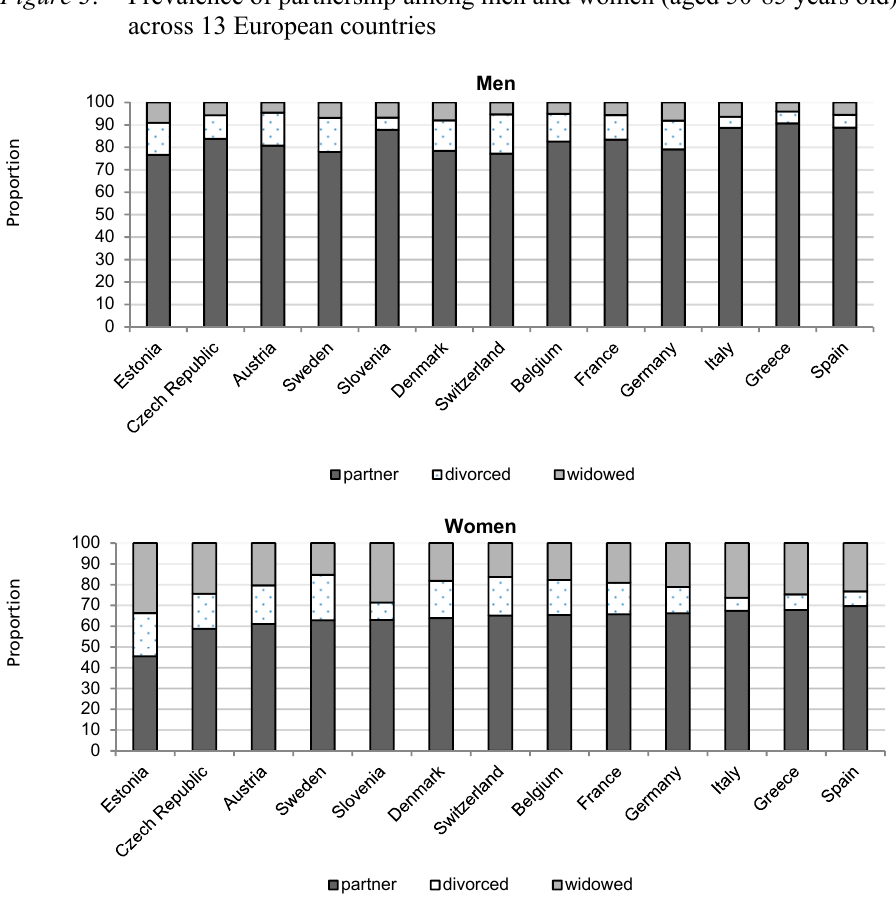
Figure 3 : Prevalence of partnership among men and women (aged 50-85 years old) across 13 European